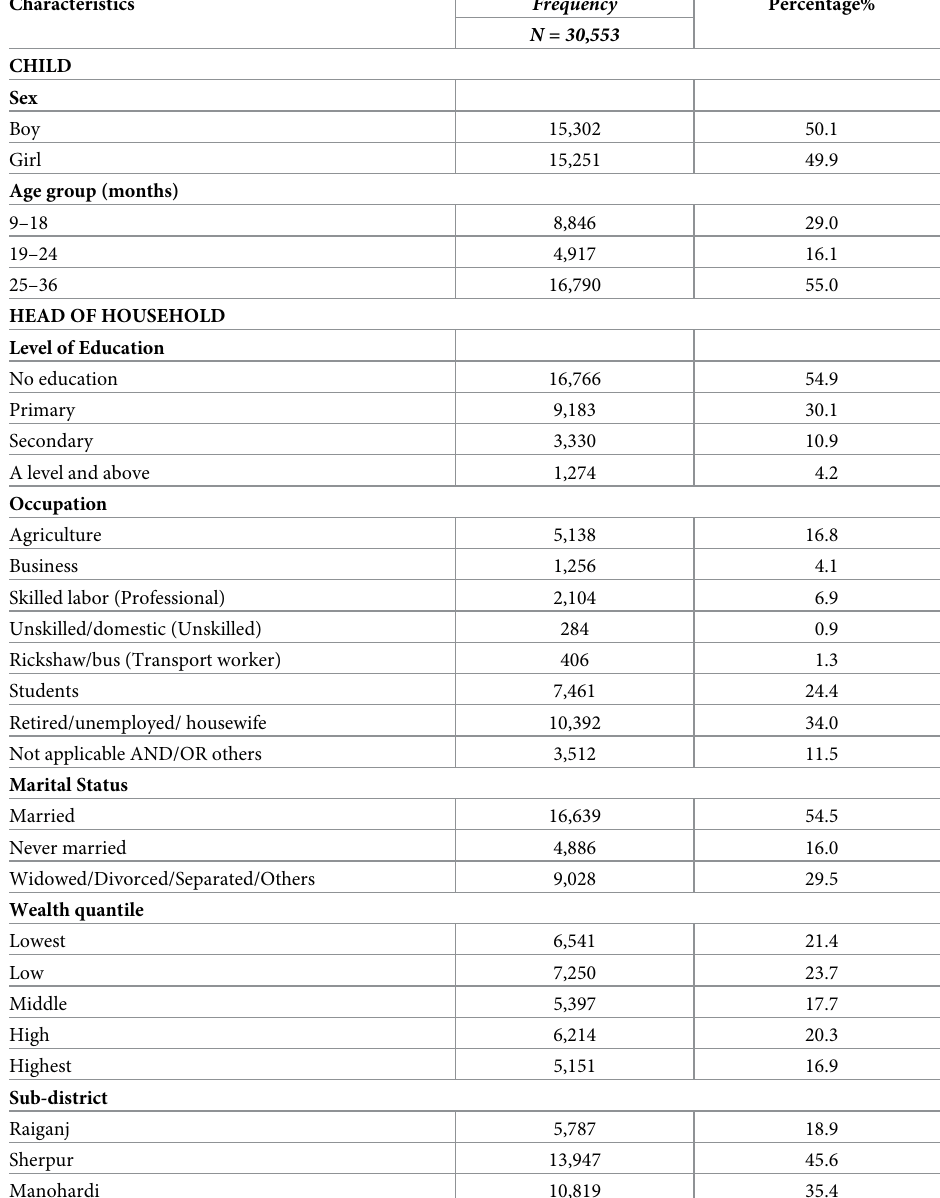
Table 2. Socio-demographic characteristics among the playpen recipients.